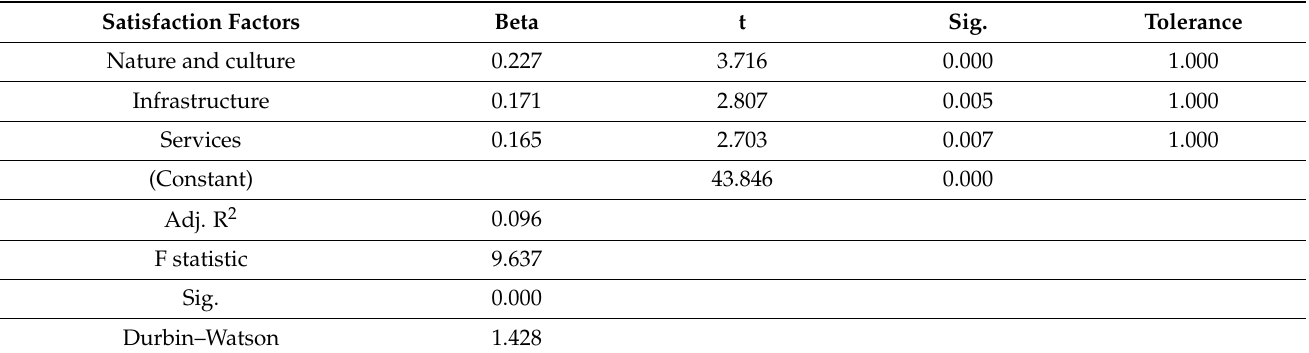
Table 2. Relationship of satisfaction factors with return intentions (Multiple regression).